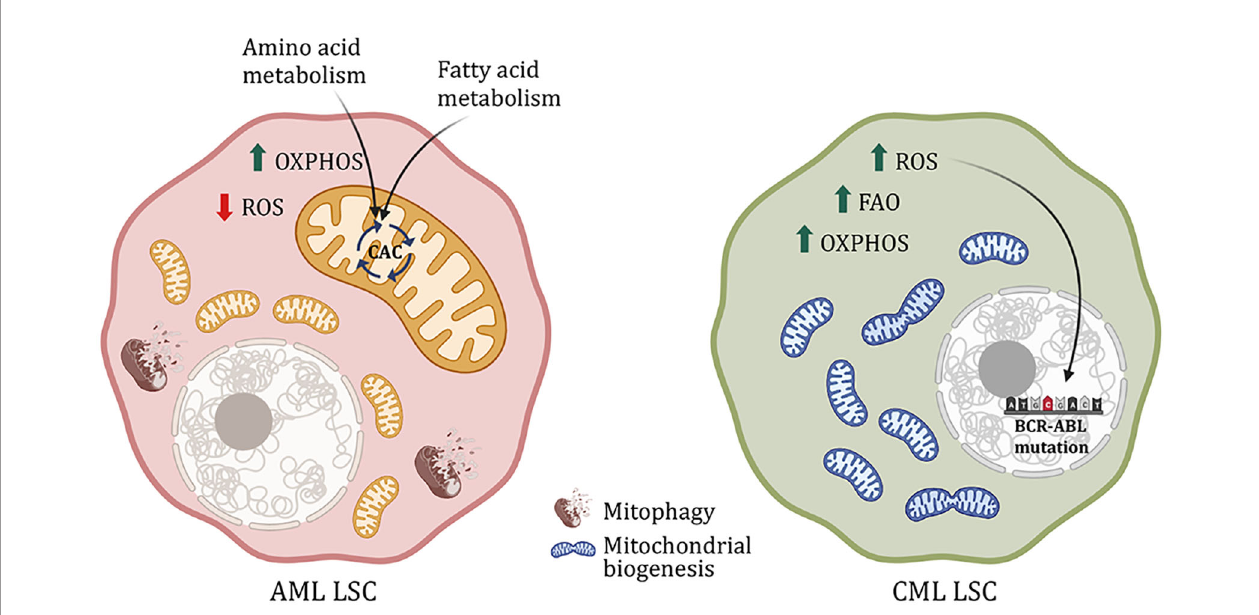
FIGURE 2 | Metabolic difference between AML and CML LSCs. AML LSCs are reliant on OxPhos and yet have low ROS level controlled by mitophagy. Moreover, AML LSCs use amino acid and fatty acid metabolism to fuel the citric acid cycle. CML LSCs on the other hand exhibit increased mitochondrial biogenesis, FAO, OXPHOS and ROS. ROS leads to DNA instability and subsequently. Causes mutation in the BCR-ABL oncogene, rendering the cells resistant to drug